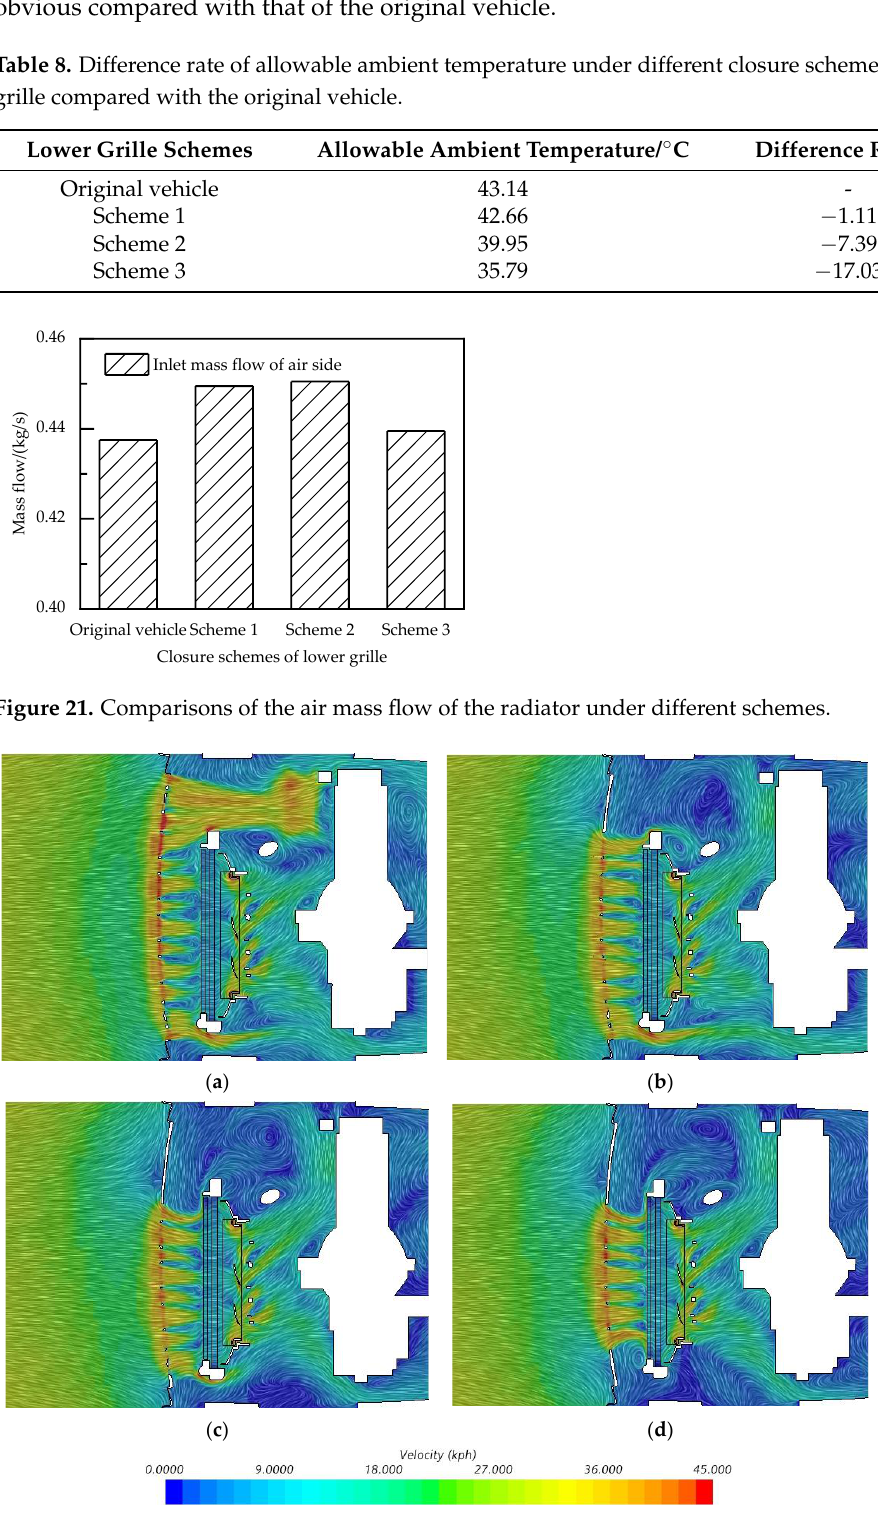
Figure 22. Velocity fields of z = 0.08 m section under different lower grille closure schemes: ( a ) original vehicle; ( b ) scheme 1; ( c ) scheme 2; ( d ) scheme